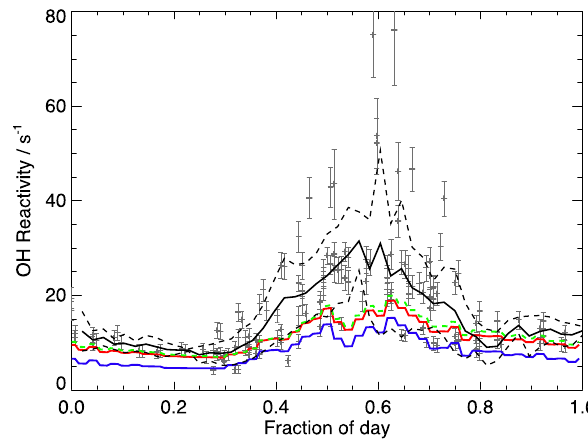
Figure 12: OH reactivity observations (black points) plotted as an average diurnal, with error bars indicating +/-1 sigma uncertainty on each observation. The solid black line is the mean diurnal profile, averaged into 30 min time bins, with the dashed black lines indicating +/- 1 standard deviation within that 30 min bin. The solid red line shows the modelled OH reactivity from the base model simulation (described in Sect. 5) with OH concentrations constrained to their mean observed value. The blue line shows the calculated OH reactivity in a model simulation where the OH concentration has been calculated by the MCM v3.2 chemistry scheme. The green dashed line shows the calculated OH reactivity using the same constraints as the base model simulation (red line), but using the MCM v3.1 chemistry scheme (Sect. 6.2).